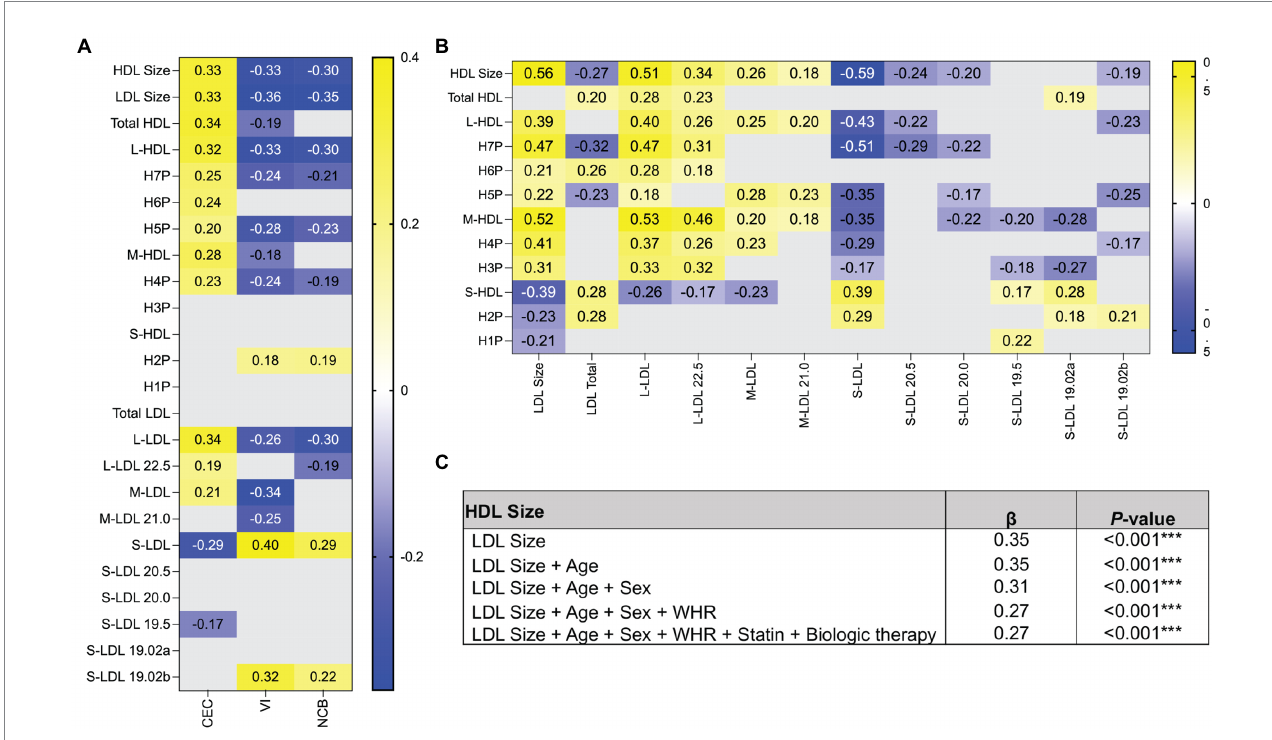
FIGURE 1 The relationship between VI and NCB and small and large lipoproteins differs in directionality. (A) Spearman correlation coefficients were determined between HDL and LDL subgroups and CEC, VI, and NCB. The correlation coefficients displayed represent significant associations. (B) Spearman correlation coefficients were calculated between the concentrations of HDL and LDL within subgroups to determine if the concentrations of each subgroup were interdependent. (C) Linear regression analysis of HDL and LDL size show that lipoprotein size has a robust relationship. All data in heatmap are expressed as Spearman’s correlation coefficient. Only significant values are reported. p ≤ 0.05 deemed significant. *** p < 0.001. HDL, high-density lipoprotein; LDL, low- density lipoprotein; H1P-H7P, HDL subgroups by size; L, large; M, medium; S, small; CEC, cholesterol efflux capacity; VI, vascular inflammation; NCB, non- calcified coronary burden; WHR, Waist-to-Hip